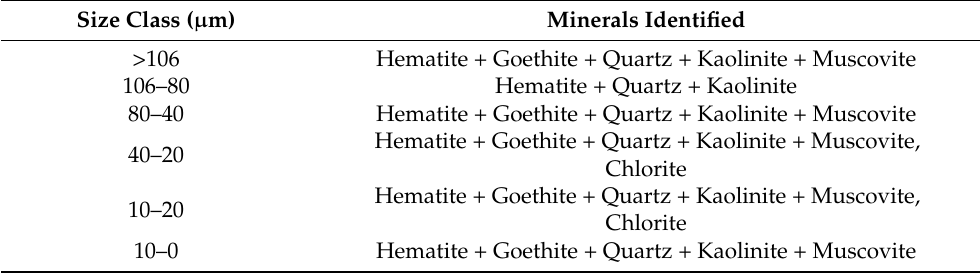
Table 3. Summary of the identified minerals present in the slimes sample via XRD by different size